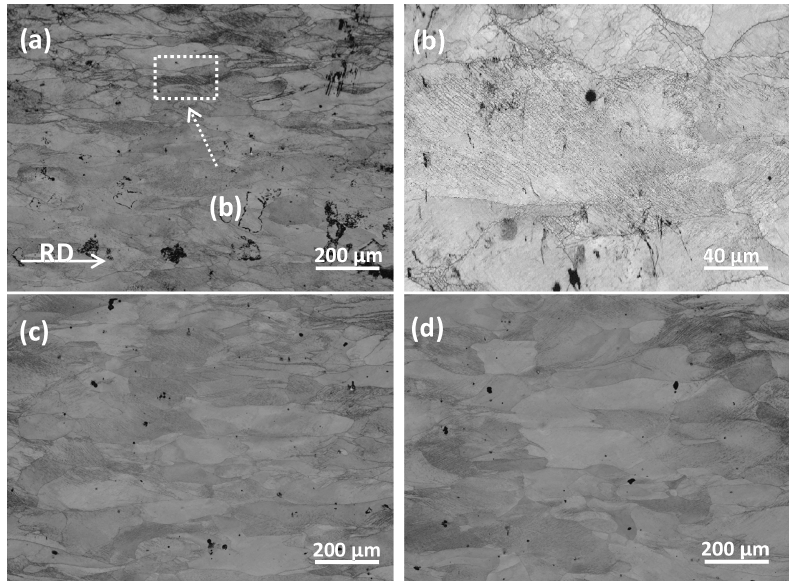
Figure 4. Band contrast images of ferrite rolled IF steels with ( a ) dry, ( b ) the magnified shear band in ( a ), ( c ) lubricating oil, and ( d ) polyphosphate lubricant conditions at 700 °C with 40% rolling reduction.